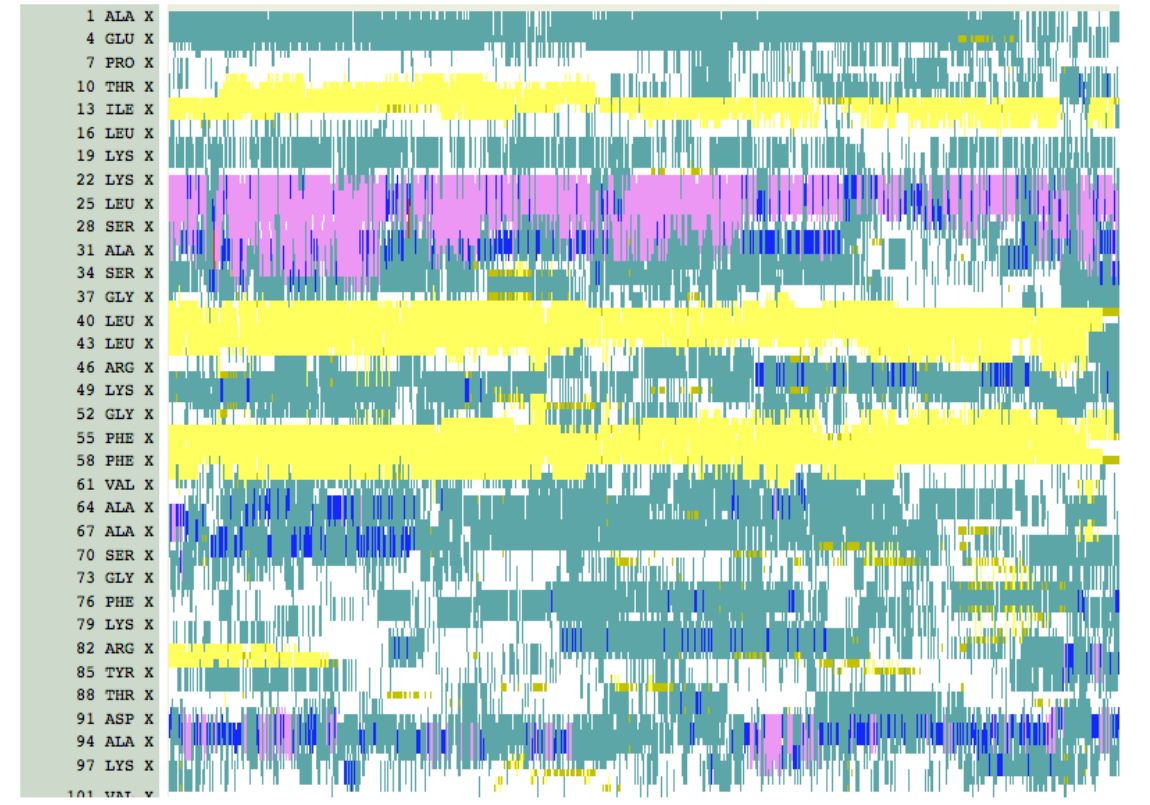
Figure 9. Evolution of secondary structure in the MDUF trajectory #1 of U1A. Key: Yellow: β -sheets. Red: α -helices. This plot was obtained using VMD [68].